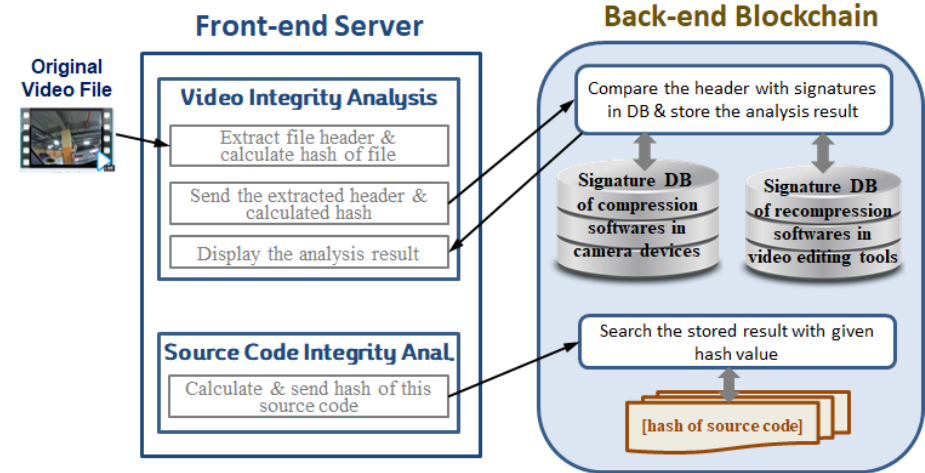
Figure 4. Detailed structure of integrity analysis